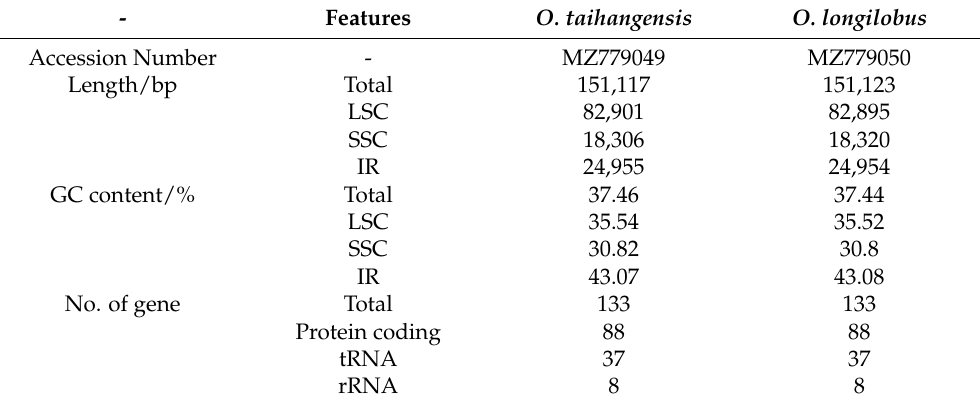
Figure 1. Gene map of O. taihangensis and O. longilobus . Genes lying outside the outer circle are transcribed in a counter-clockwise direction, and genes inside this circle are transcribed in a clockwise direction. The colored bars indicate known protein-coding genes, transfer RNA genes, and ribosomal RNA genes. The dashed, dark grey area in the inner circle denotes GC content, and the light grey area indicates genome AT content. LSC, large single-copy, SSC, small single-copy; IR, inverted repeat. Table 1. Summary of the plastome features for O. taihangensis and O. longilobus . LSC: large single-copy region; SSC: small single-copy region; IR: inverted